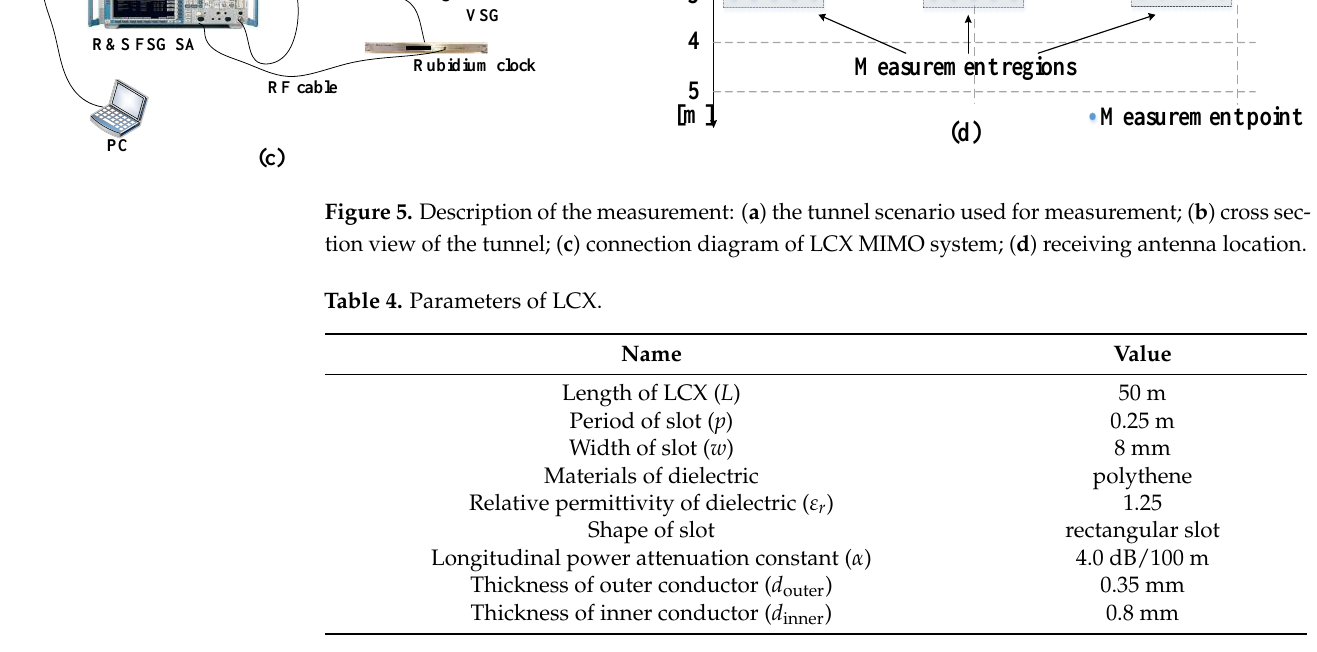
Table 4. Parameters of LCX .